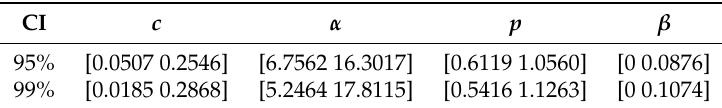
Table 5. Confidence intervals of OGWG for data set 1.